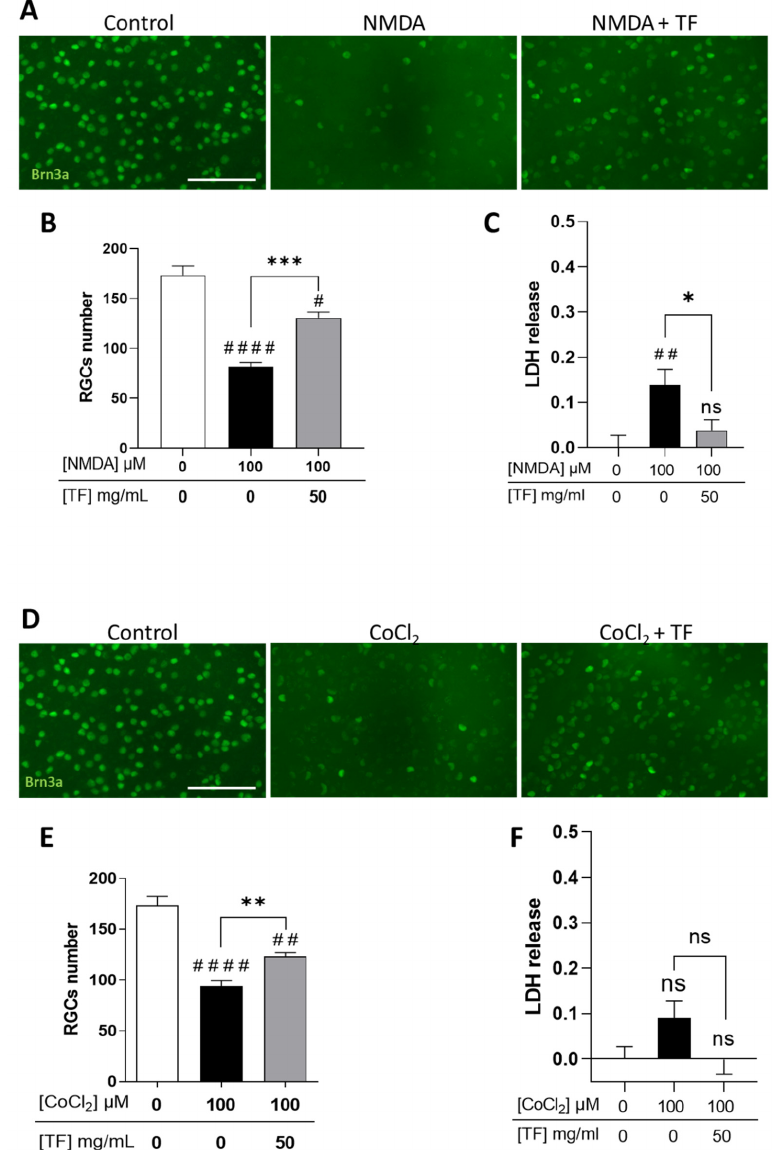
Figure 2. Transferrin protects RGCs in NMDA- or CoCl 2 -treated retinal explants. ( A ) Representative images of retinal whole-mounts prepared for Brn3a immunostaining following 24 h incubation with 100 µ M NMDA or TF (50 mg/mL) combined with NMDA and further cultured for 72 h (96 h total) in presence or not of TF. Untreated explant served as control. ( B ) Brn3a-positive cells were counted showing that TF significantly protects RGCs against NMDA-induced cell death. ( C ) LDH released by explants during 3 h to 24 h of culture was significantly increased in presence of 100 µ M NMDA and absent in additive presence of TF. ( D ) Representative images of retinal whole-mounts prepared for Brn3a immunostaining following 24 h incubation with 100 µ M CoCl 2 or TF (50 mg/mL) combined with CoCl 2 and further cultured for 72 h (96 h total) in presence or not of TF. Untreated explant served as control. ( E ) Brn3a-positive cells were counted showing that TF significantly protects RGCs against CoCl 2 -induced cell death. ( F ) LDH released by explants during 3 h to 24 h of culturing was significantly increased in presence of 100 µ M CoCl 2 and absent in additive presence of TF. Data represent means ± SEM, n = 6–10 explants per condition. Statistical analysis was performed with Kruskal–Wallis and Dunn’s tests for multiple comparisons. ns: not significant; # p < 0.05; ## p < 0.01; #### p < 0.0001 compared to control. ns, not significant; * p < 0.05 ** p < 0.01; *** p < 0.001; compared to stress condition. Scale bar: 100 µ